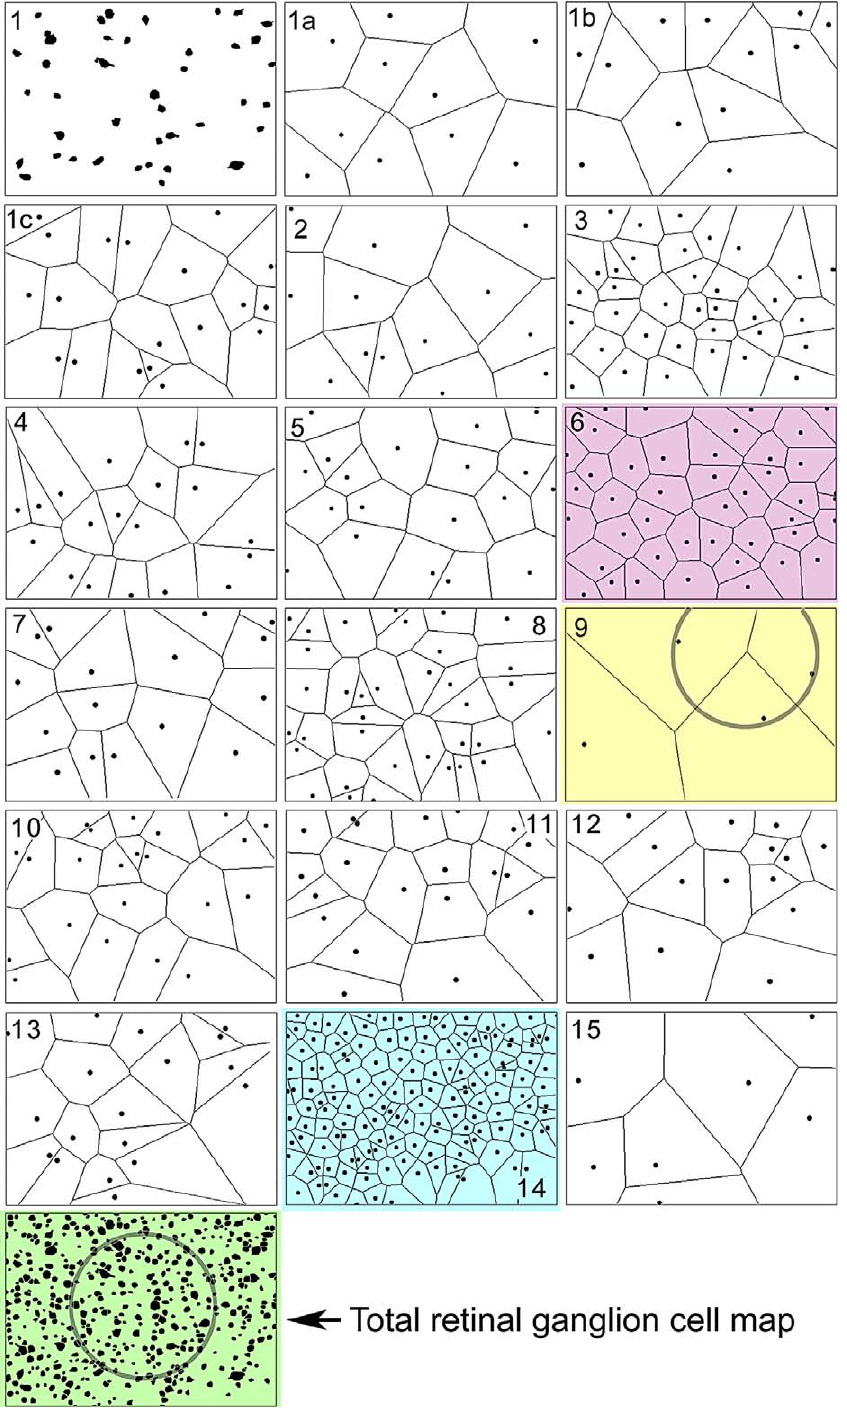
Figure 2. Voronoi Tiling of GC Classes in the Rabbit Retina Panels 1–15 represent GC or AC groups defined by CMP [5]. The bottom panel is the aggregate GC pattern. Each class forms its own independent tiling. Class 6 (red) is the most orderly. Class 9 (yellow) is the rarest and defines a canonical field for the GC cohort, containing three members of the class. Class 14 (cyan) is the densest and is the starburst displaced AC population. The canonical field superimposed on the entire GC cohort (green) captures . 100 cells and guarantees a robust sample of all network types. Modified from Marc and Jones [5].